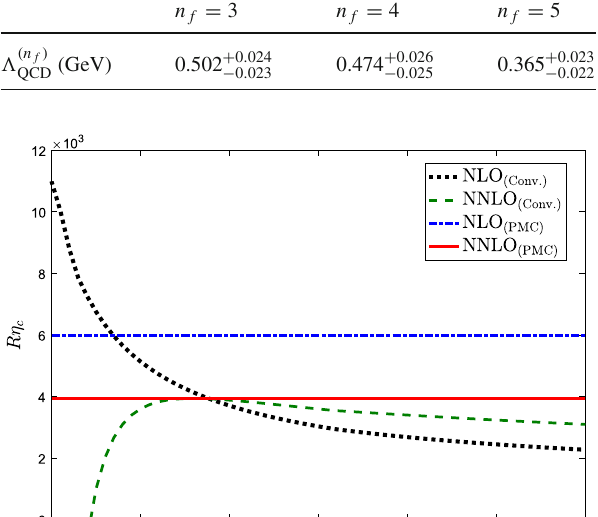
Table 1 The determined asymptotic scale (cid:9)